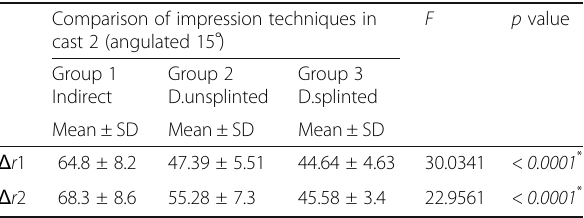
Table 3 Comparison of impression techniques in cast 2 using one-way ANOVA F Comparison of impression techniques in cast 2 (angulated 15 ৹